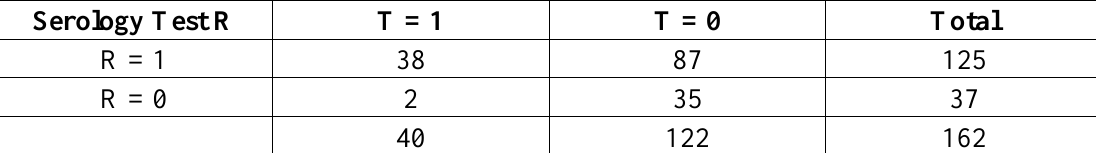
Table 20. Results of a stool exam T and a serologic reference exam R.